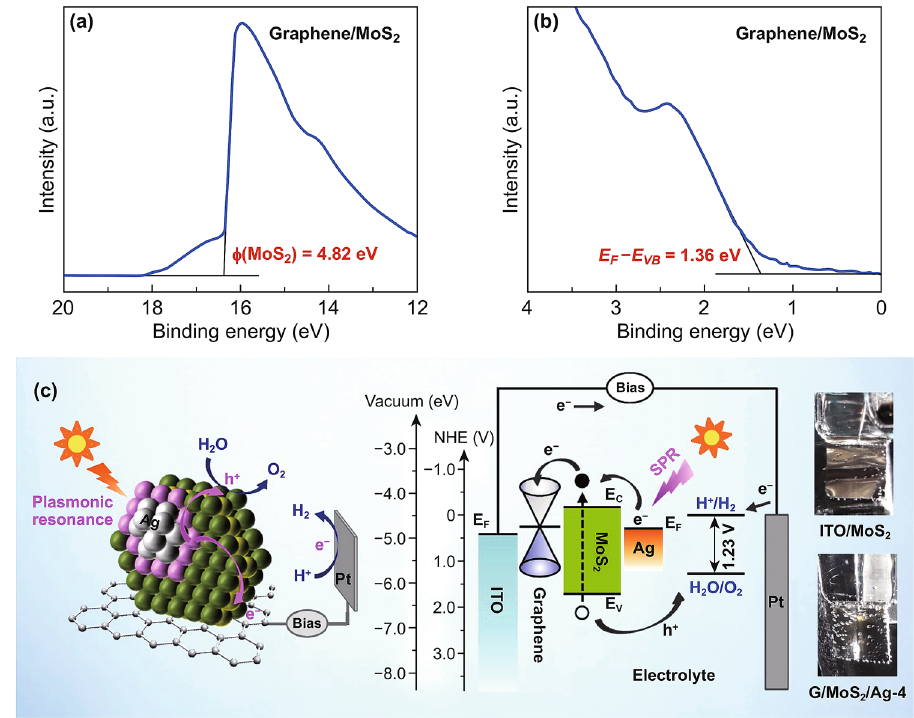
Fig. 7 a UPS secondary electron cutoff and b valence spectra of G/MoS 2 . c PEC water‑splitting working principle of plasmonic Ag‑decorated vertically aligned few‑layer